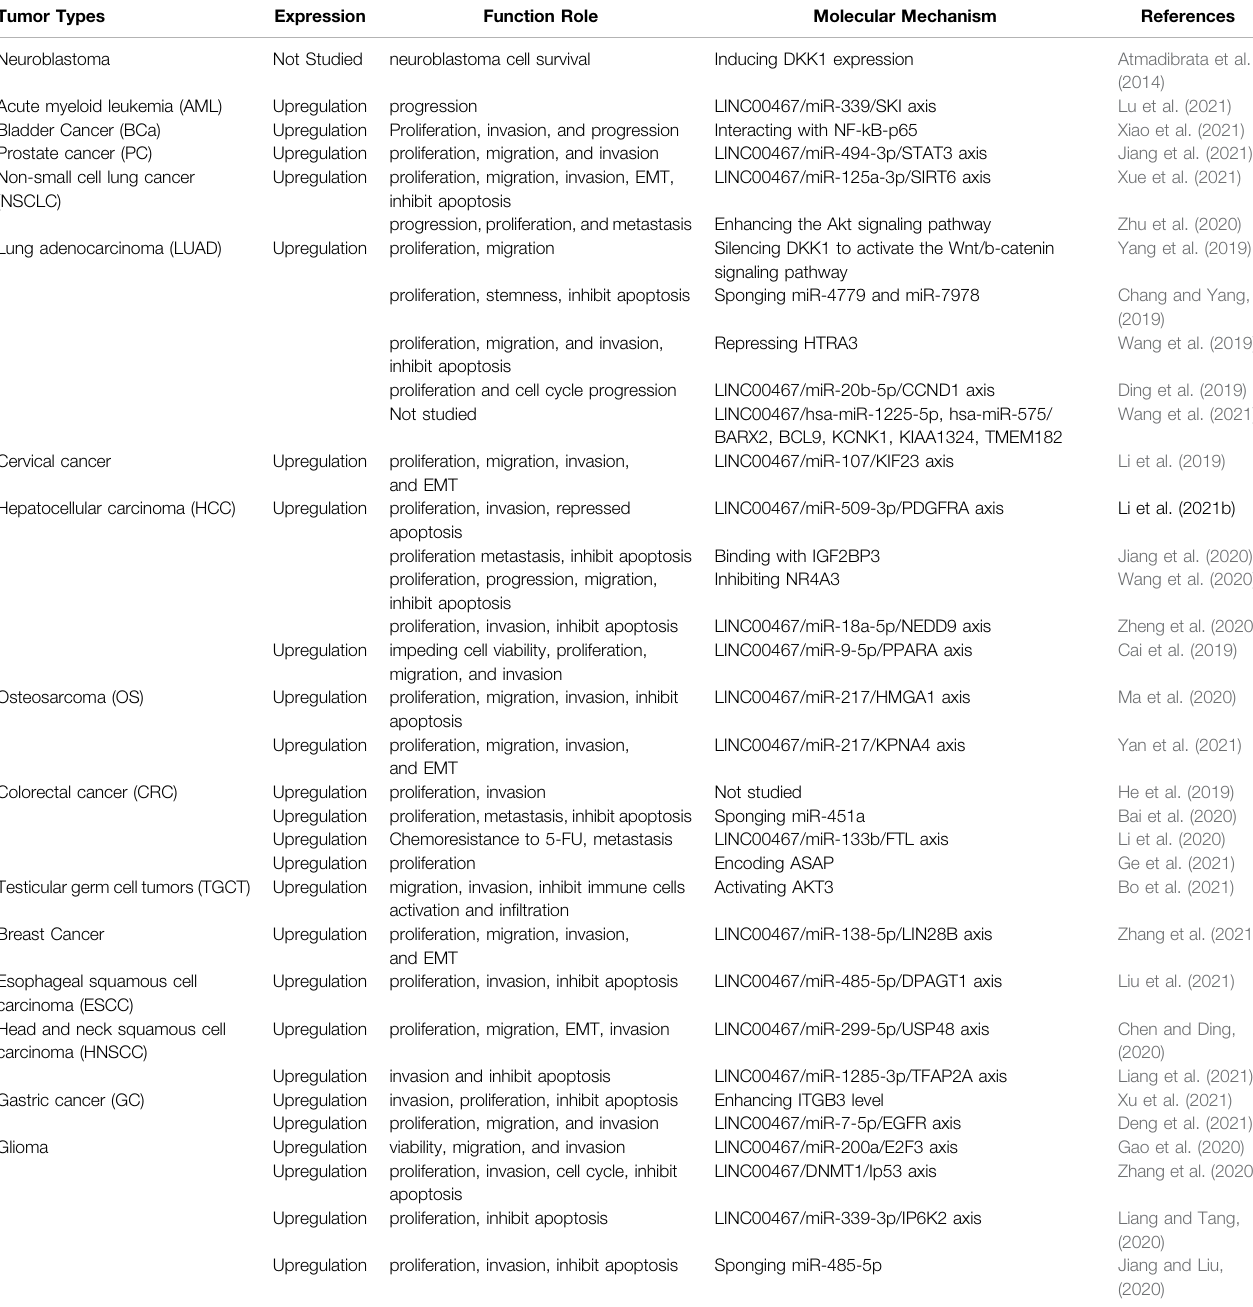
TABLE 2 | Functional molecular mechanisms of LINC00467 in various